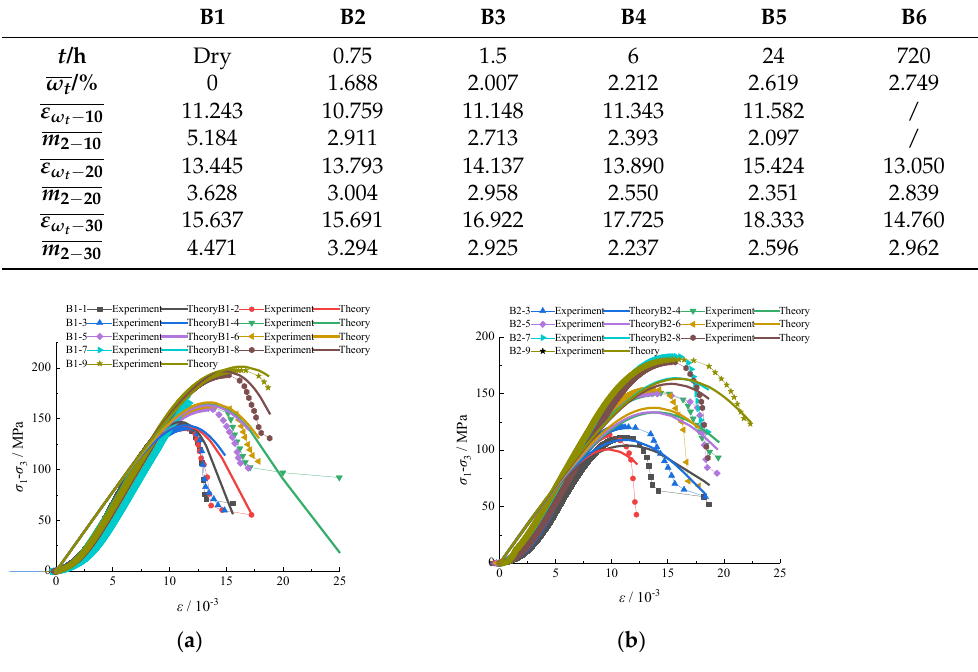
( f ) Figure 10. The stress-strain experimental curves and theoretical damage curves of sandrock con- taining water under triaxial compression status. ( a ) Dry Sample; ( b ) Sample Submerged for 0.75 h; ( c ) Sample Submerged for 1.5 h; ( d ) Sample Submerged for 6 h; ( e ) Sample Submerged for 24 h; ( f ) Sample Submerged for 720 h. According to Figures 9 and 10, under both uniaxial and triaxial loading conditions, the overall shape of the theoretical rock damage curve is similar to the overall shape of the experimental curve, indicating that the theoretical curve of water-containing rock damage evolution can better reflect the sandstone damage under different water contents. Before reaching peak strength, the rock deformation exhibits linear elasticity, and after peak strength, the strength decreases rapidly. With the increase of confining pressure, the theoretical damage curve gradually slows down, which proves that the ability of rock to resist damage increases gradually with the additional increase of confining pressure.